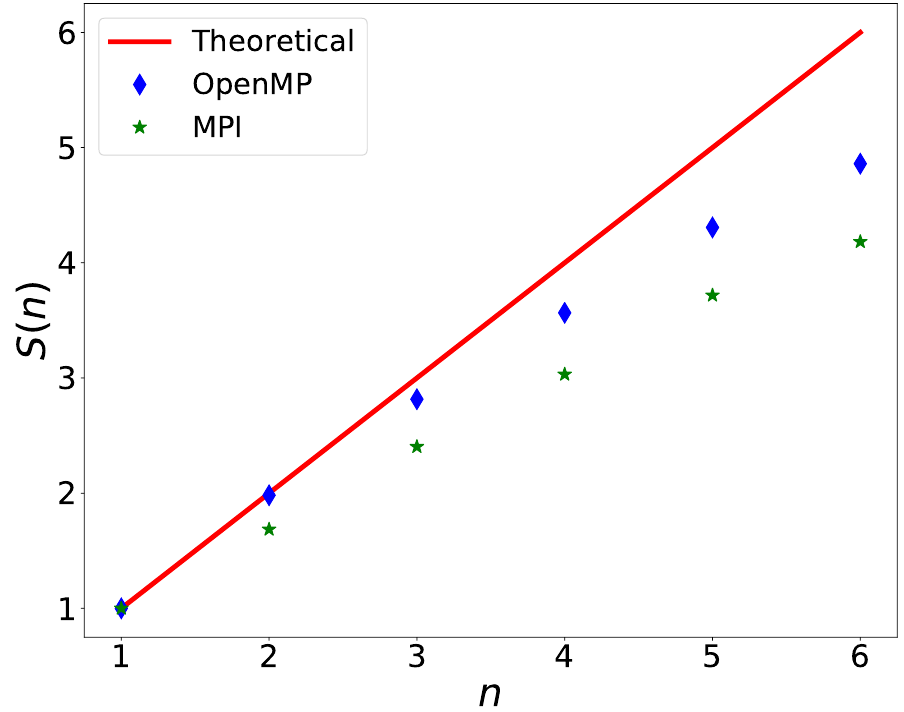
Figure 3. Comparison between the theoretical (red solid line), OpenMP (blue diamonds) and MPI (green stars)